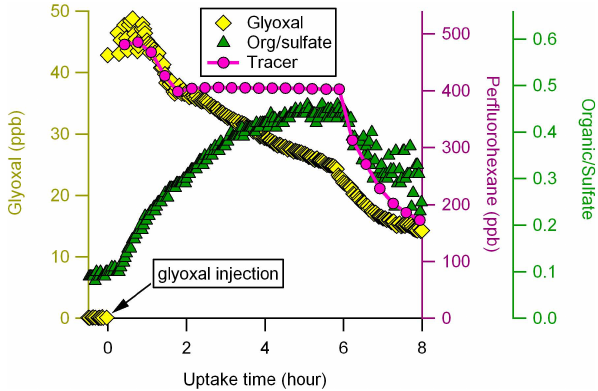
Fig. 2. Typical time traces of glyoxal, organic/sulfate ratio, and tracer (perfluorohexane) during toluene-NO x photooxidation (Run 1368A). Immediately after glyoxal injection, organic/sulfate ratio increased. Upon dilution at 6h after injection, organic/sulfate ratio decreased due to evaporation of organics, consistent with Galloway et al. (2009).